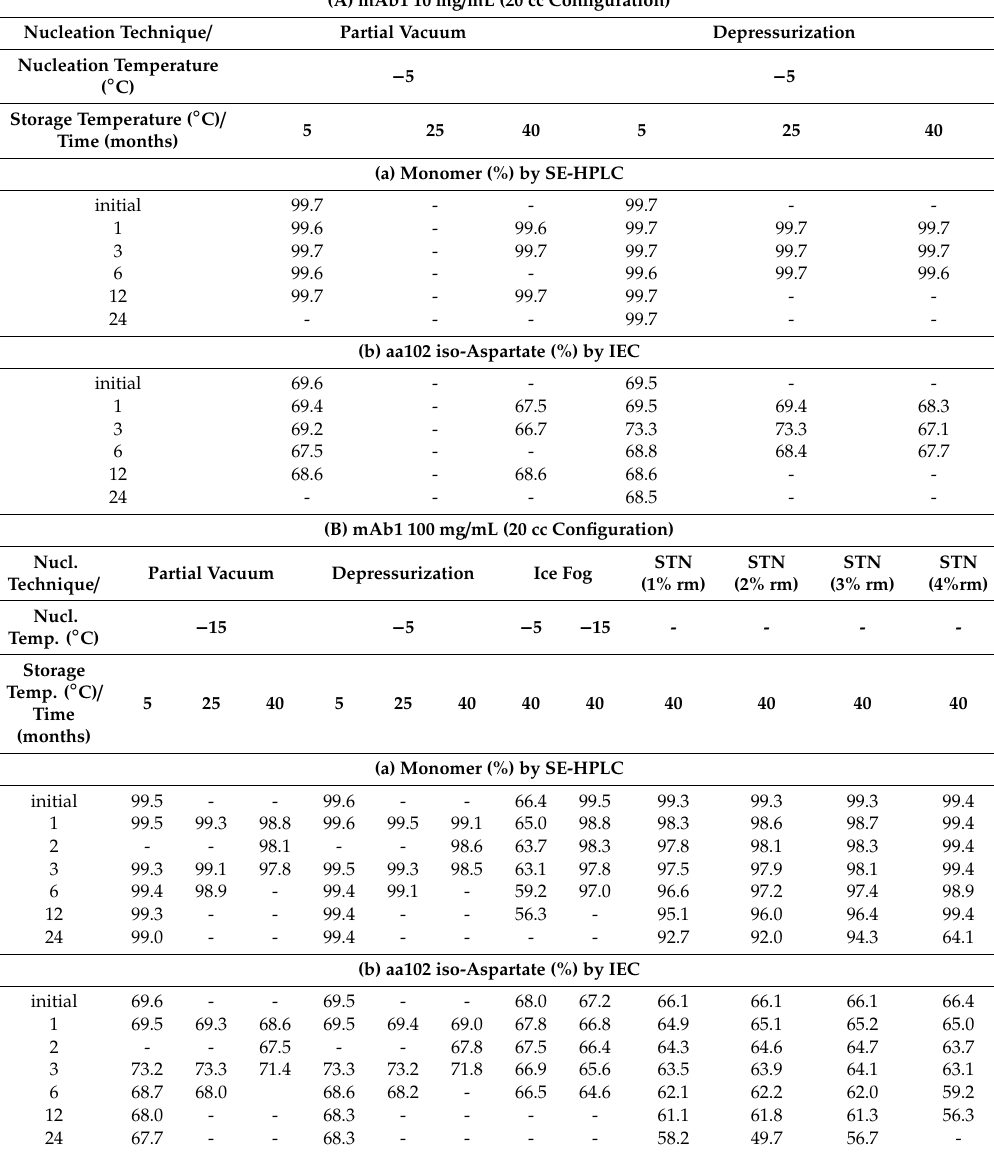
Table A1. Stability of mAb1 at a protein concentration of ( a ) 10 mg / mL or ( b ) 100 mg / mL in the 20 cc configuration. ( A ) Monomer analyzed by SEC. ( B ) Iso-Aspartate formation (amino acid aa102) by IEC. Values are presented as measured and not normalized as performed in the main manuscript for direct comparison to controls. STN = stochastically nucleated rm = residual